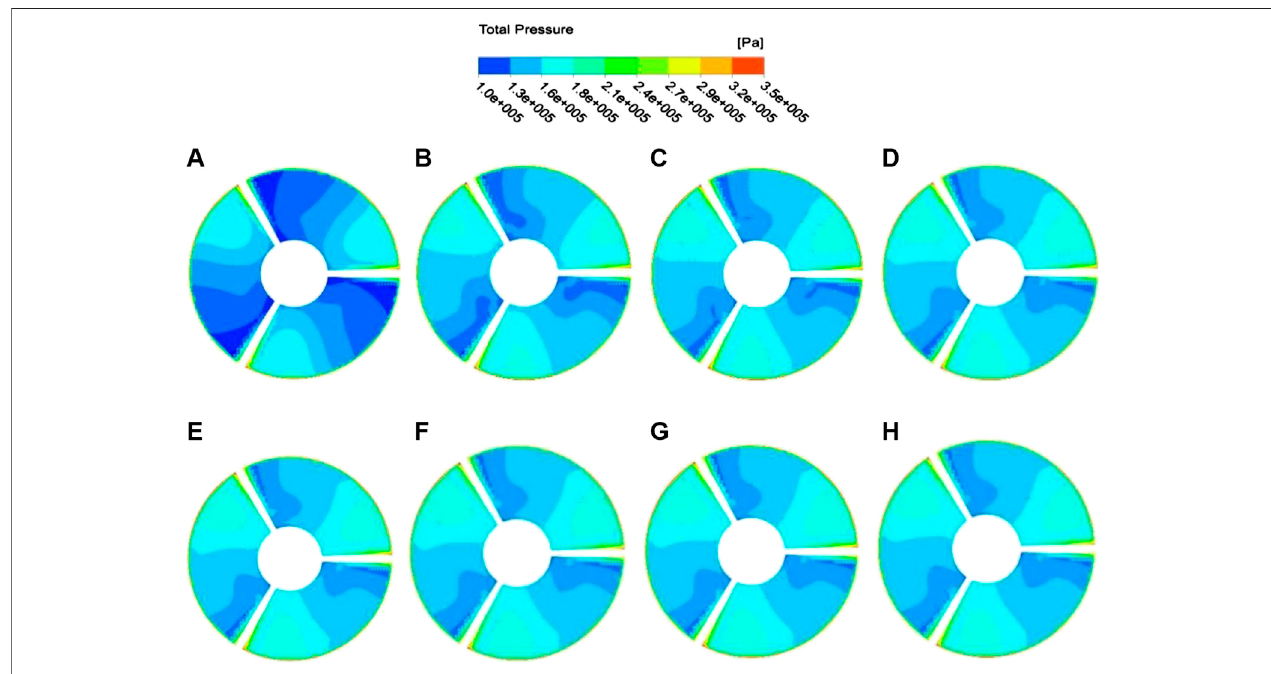
FIGURE 11 | Internal pressure distribution in the shaft section of the secondary impeller with different inter-stage gaps. (A) D L1 (cid:1) 0.00 L (B) D L2 (cid:1) 0.25 L (C) D L3 (cid:1) 0.50 L (D) D L4 (cid:1) 0.75 L (E) D L5 (cid:1) 1.00 L (F) D L6 (cid:1) 1.25 L (G) D L7 (cid:1) 1.50 L (H) D L8 (cid:1) 2.00